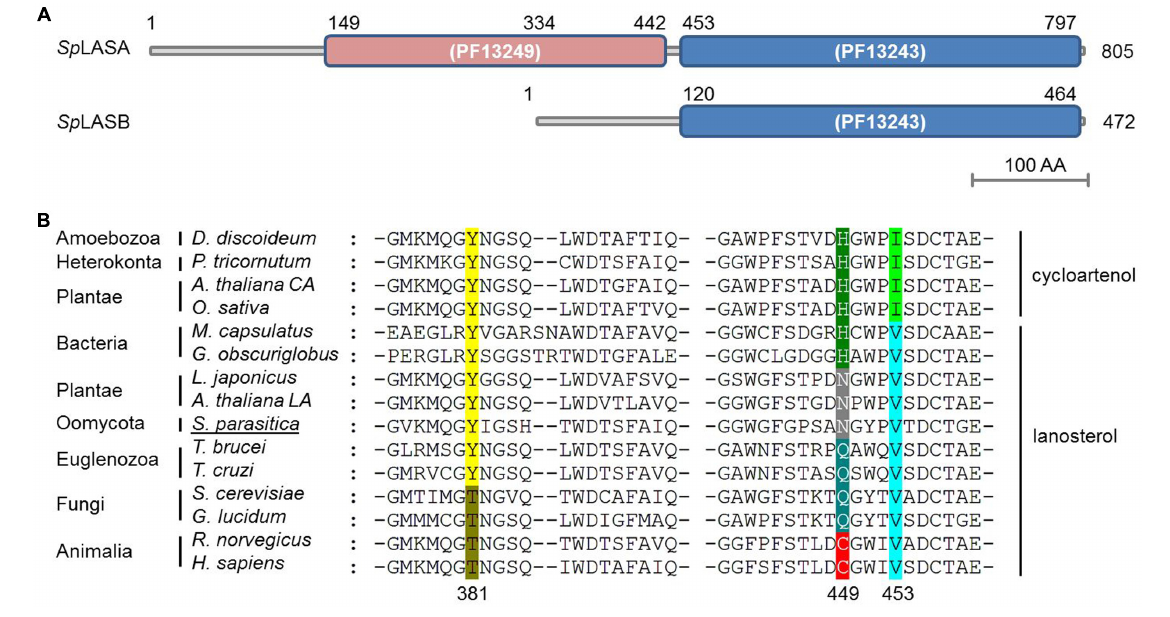
FIGURE 2 | Predicted domains of the two OSC enzymes from S. parasitica ( Sp LASA and Sp LASB) and sequence alignment with similar enzymes from different taxa. (A) Sp LASA (SPRG_11783) contains two separate Pfam squalene-hopene cyclase domains. Sp LASB (SPRG_17895) contains the C-terminal domain only. (B) Protein sequence alignment of diverse OSC enzymes highlighting a key amino acid triad involved in enzyme. The numbers given for the positions of the three amino acids are from the human OSC. Variations in these positions are highlighted with different colors and the enzymes are grouped into LAS and CAS. The S. parasitica sequence shown is from Sp LASA. Arabidopsis thaliana CA and A. thaliana LA refer to the CAS and LAS enzymes from A. thaliana ,